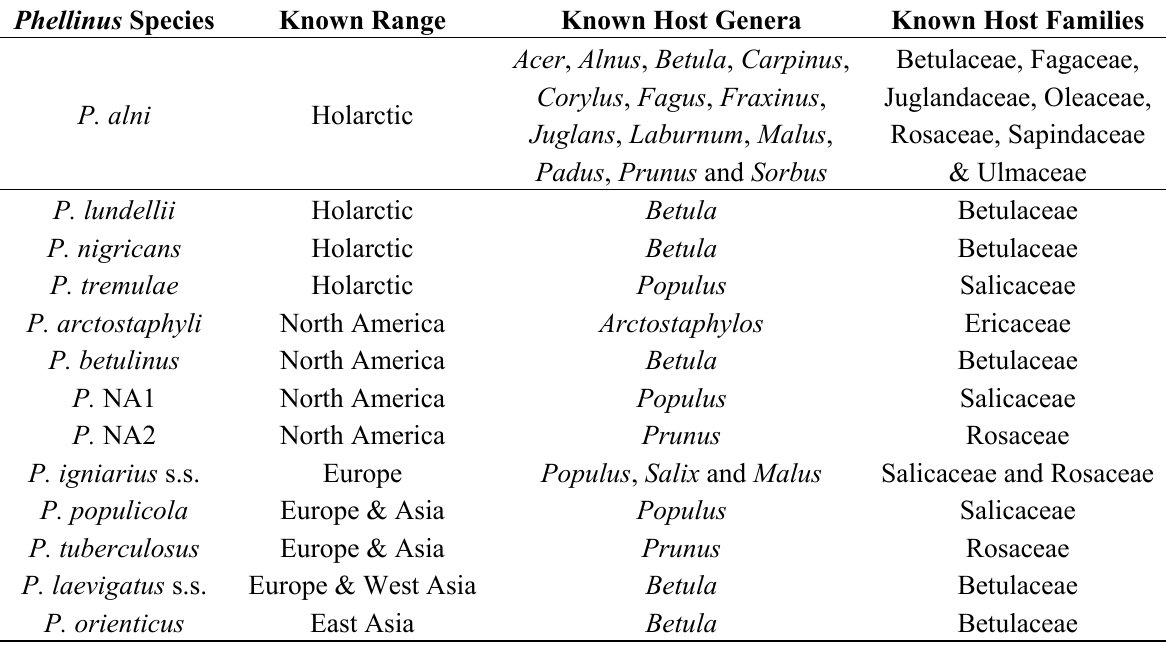
Table 2. Known range, host genera and host families of Phellinus s.s.